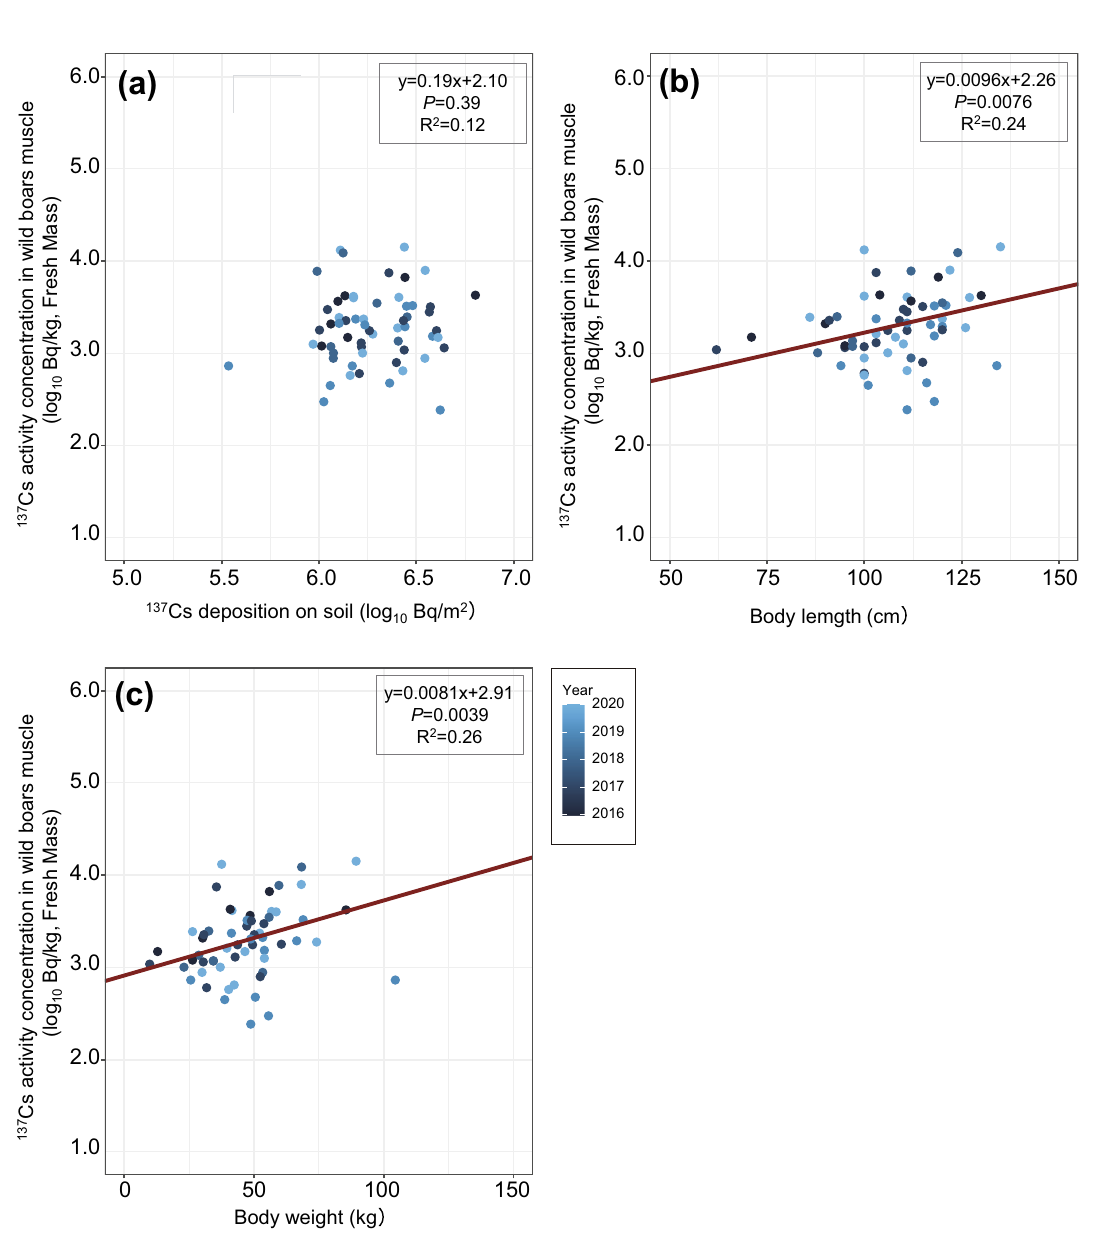
Figure 6. Relationships between the 137 Cs activity concentration of wild boar muscle samples collected in the low-activity-concentration season (July to September) from inside the difficult-to-return zone (DRZ) and ( a ) 137 Cs deposition on soil (log 2 ), ( b ) body length (cm), and ( c ) body weight (kg). Results of the regression 10 Bq/m analysis are based on mixed linear models using years as random variables and the adjusted coefficient of determination (R 2 ) are shown in the figures. The linear regression equation (red line) is shown only when a significant difference between the two variables was